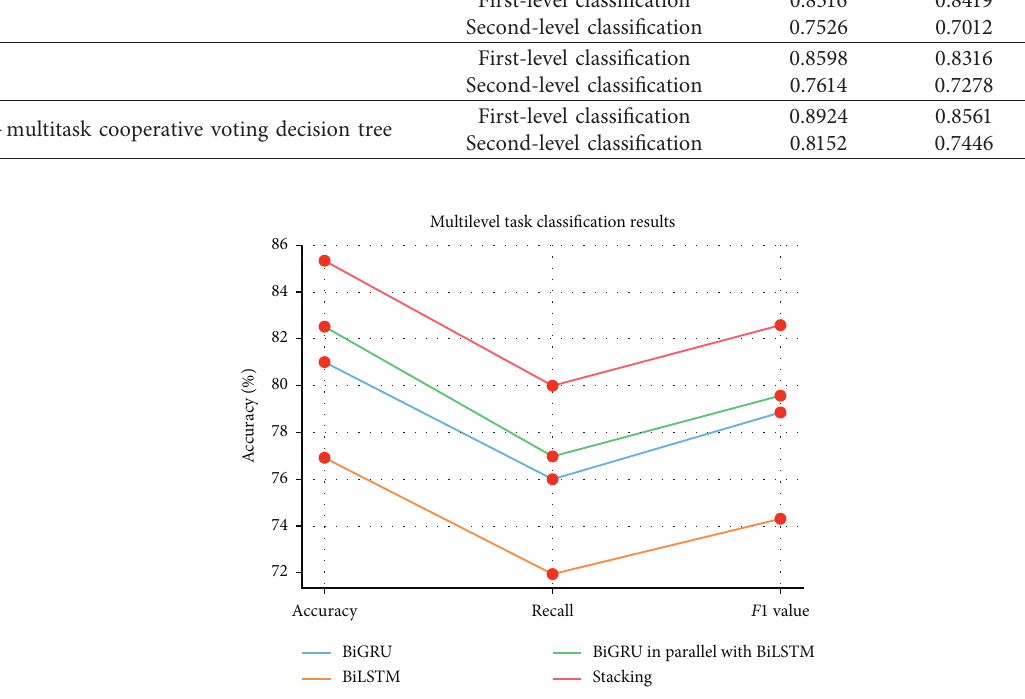
Figure 8: Comparison of classification performance of each model.